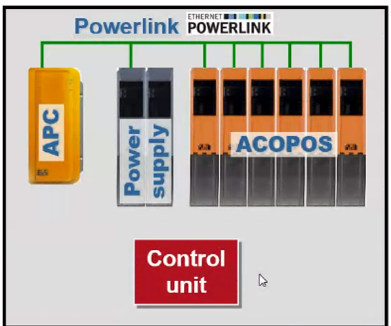
Figure 3. General control software architecture of a COMAU industrial